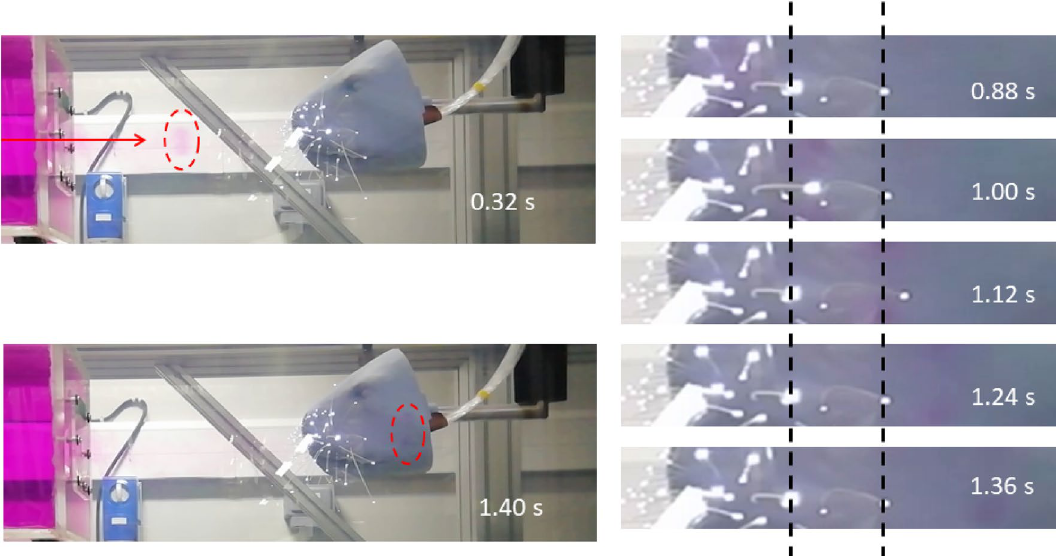
Figure 6. Picture of the 3D printed sea lion head with integrated optical whiskers, seen by the bright spots at the tips. The time series on the right-hand side with zoom-in illustrates the successive excitation of two neighbouring whiskers in the same horizontal plane when hit by the travelling vortex ring (travel direction from left to right).